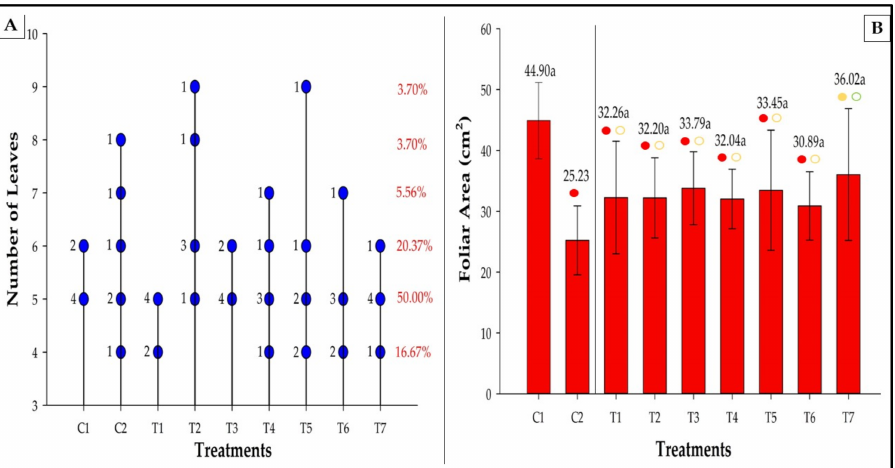
Figure 4. Number of leaves ( A ) and foliar area ( B ) of strawberries inoculated with Azospirillum brasilense , Bacillus megaterium , and Brevibacillus fluminis , alone and in mixtures. In ( A ), the values next to the bars represent the number of samples with a given number of leaves. The percentages express the proportion of the number of leaves among all observations. In ( B ), closed (